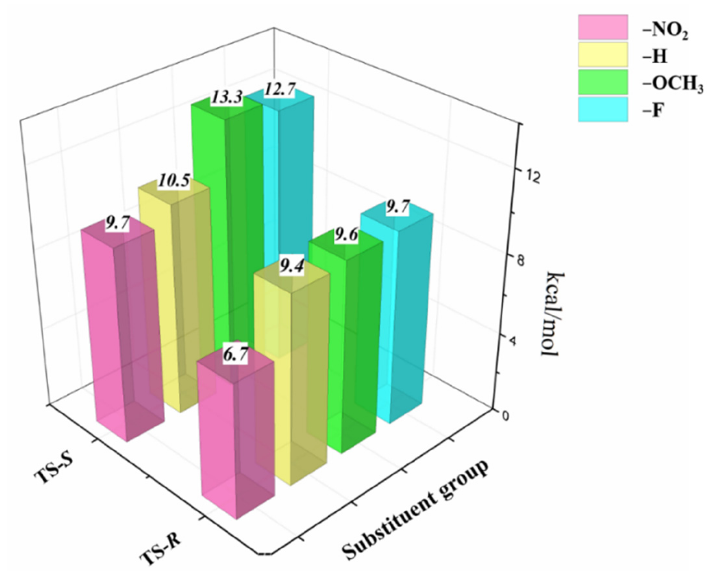
Figure 3. Activation barriers (kcal/mol) on the In-MOF in toluene.